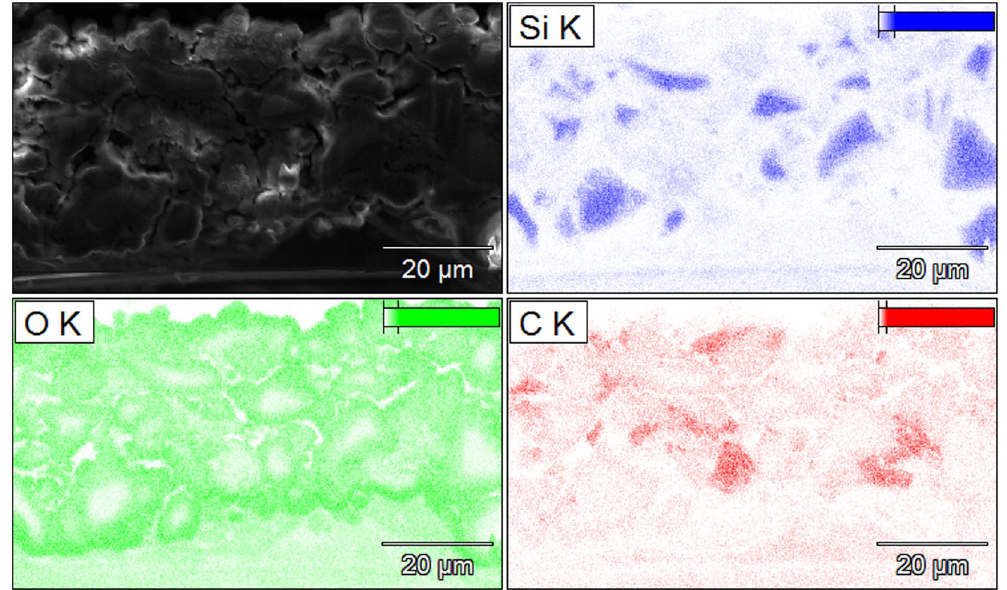
Figure 4. SEM image and corresponding EDS mapping from ion cut TCPSi electrode after 300 cycles. Silicon (Si), oxygen (O) and carbon (C) mapping after 300